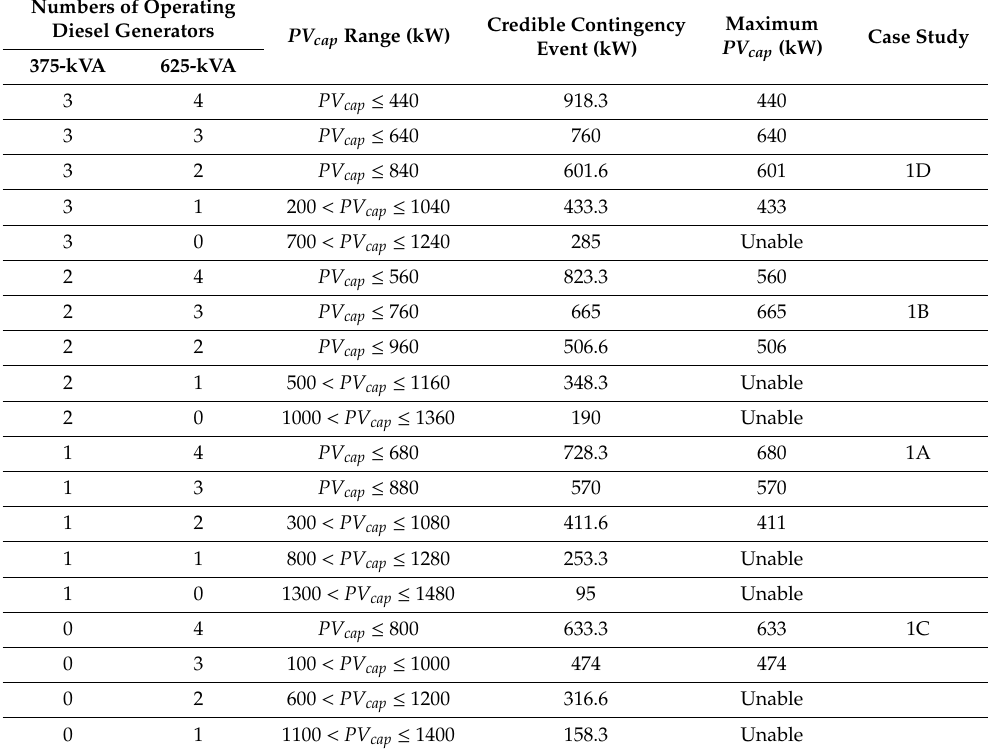
Table 5. Mathematical analysis results for quasi-steady-state frequency without the energy storage system (ESS).